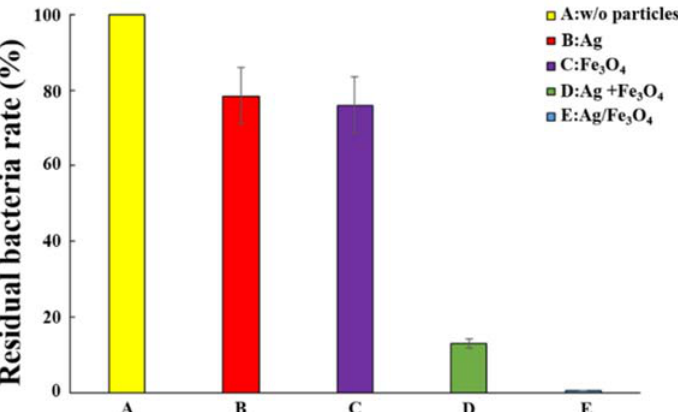
Figure 6. Comparison of antibacterial effects with different kinds of nanoparticles (NPs): (A) bacterial solution only; (B) solution with only non ‐ magnetic Ag NPs; (C) solution with only Fe 3 O 4 ; (D) solution with both Ag NPs and Fe 3 O 4 NPs; and (E) solution with Ag/Fe 3 O 4 NPs.